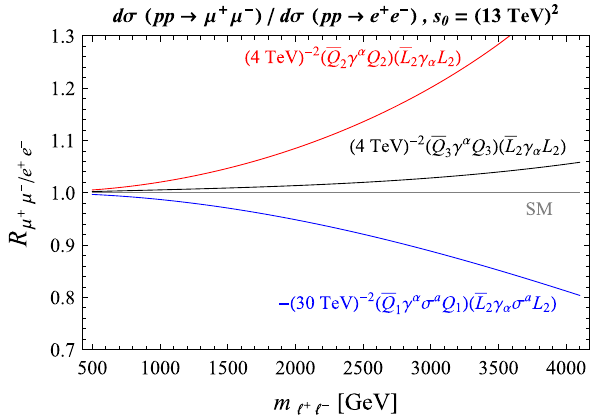
Fig. 1 R μ + μ − / e + e − as a function of the dilepton invariant mass m (cid:2) + (cid:2) − for three new physics benchmark points. See text for